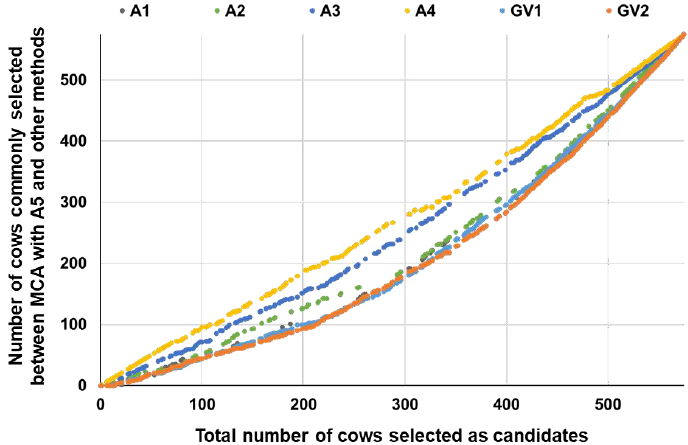
Figure 2. Changes in number of cows commonly selected between MCA with A5 matrix and other methods.